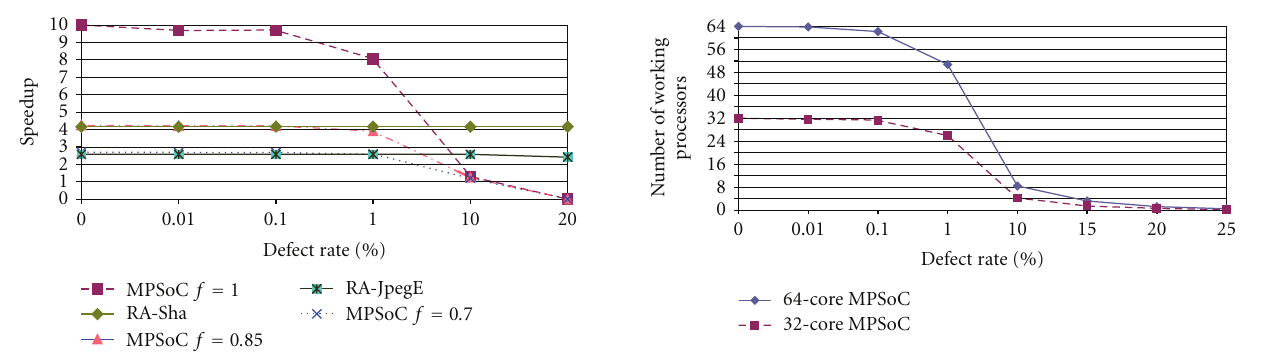
Figure 19: Defect simulation in 32-core and 64-core MPSoC— under 20% defect rate all cores fail in the 32-core MPSoC and only one core remains in the 64-core